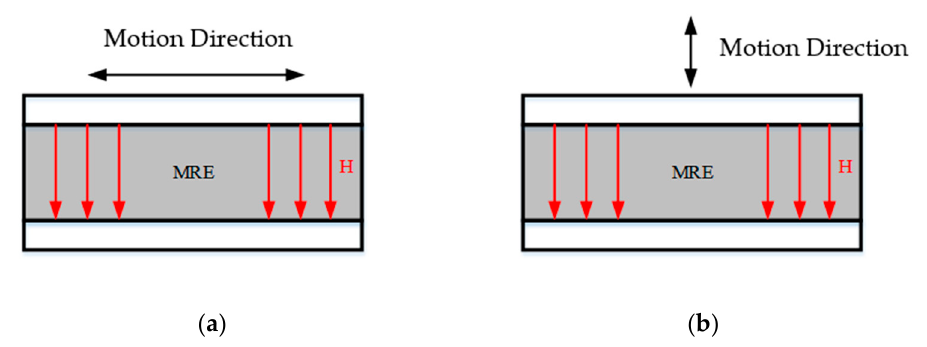
Figure 4. Operating modes of the magnetorheological elastomers: ( a ) shear mode and ( b ) pull–press mode.